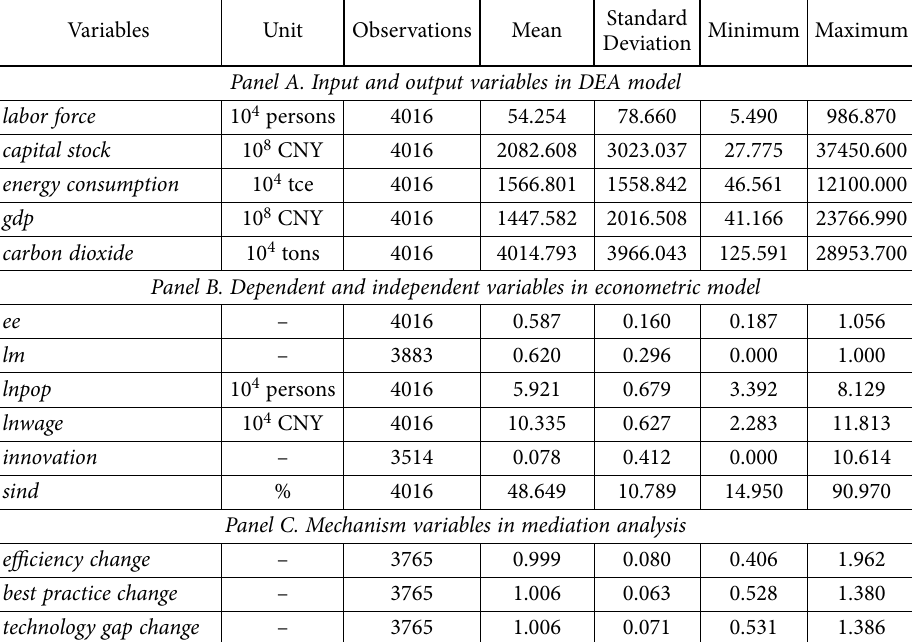
Table 1. Summary statistics